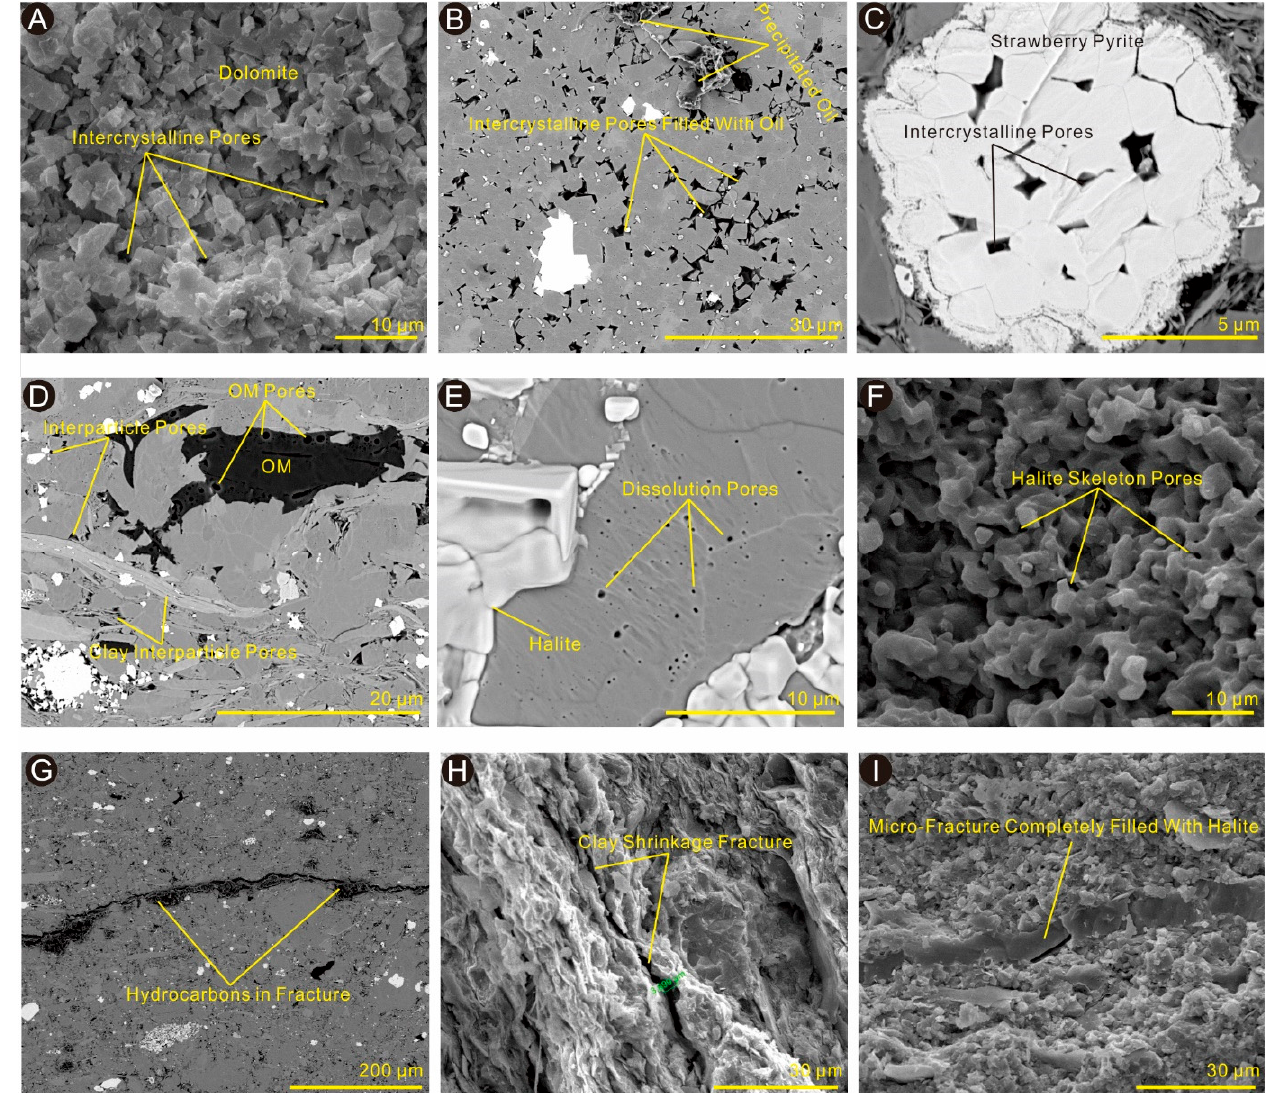
Figure 5. Representative pore types and fracture characteristics of the LXF II Oil Bed in the Jianghan Basin. ( A ) Dolomite grains smaller than 2 μ m displaying perfect rhombic or sub-rhombic shape, among which, intercrystalline pores are developed. ( B ) Intercrystalline pores are usually filled with oil. ( C ) Intercrystalline pores within pyrite aggregate. ( D ) Interparticle pores between grains and clay platelets. Rare and scattered OM pores developed in OM. ( E ) Dissolution pores within feldspar. ( F ) Pores within halite skeleton. ( G ) Fractures filled with hydrocarbons. ( H ) Clay mineral shrinkage fracture. ( I ) Micro-fracture filled with halite.